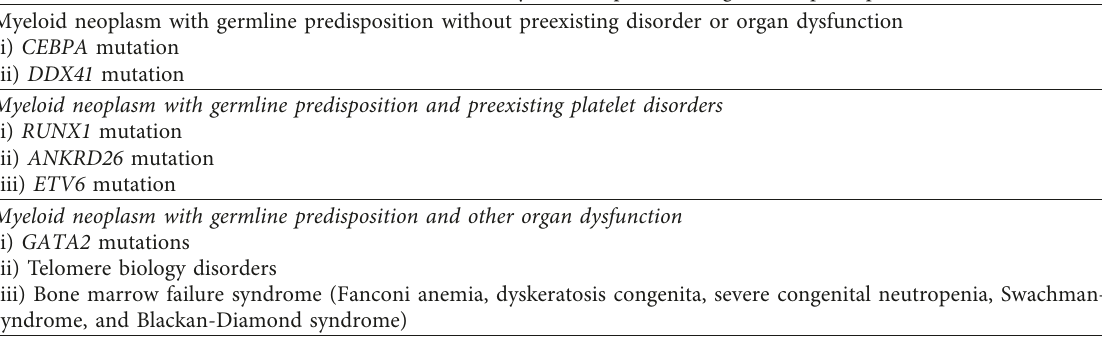
Table 1: WHO-defined myeloid neoplasm with germline predisposition.